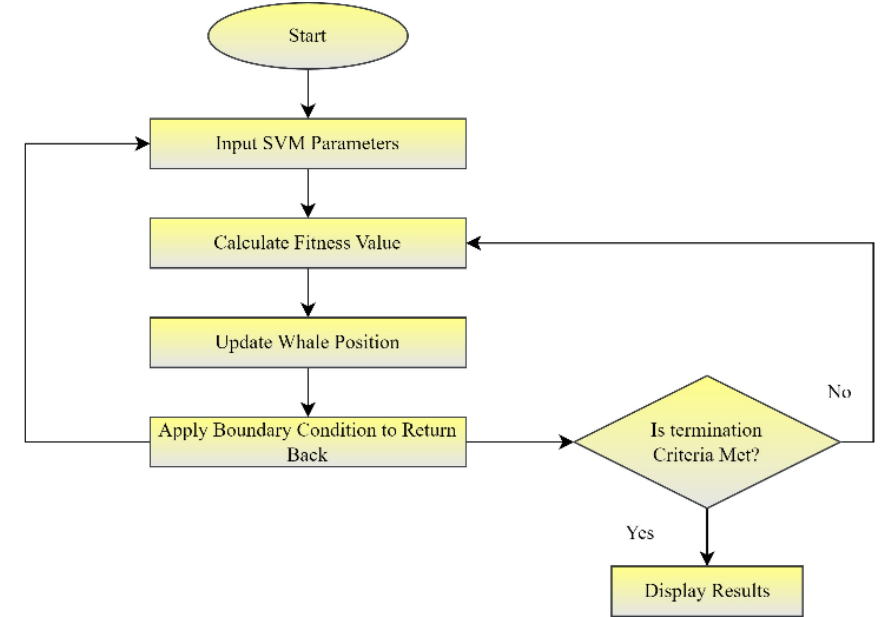
Figure 9. WOA ‐ SVM Algorithm. Figure 9. WOA-SVM